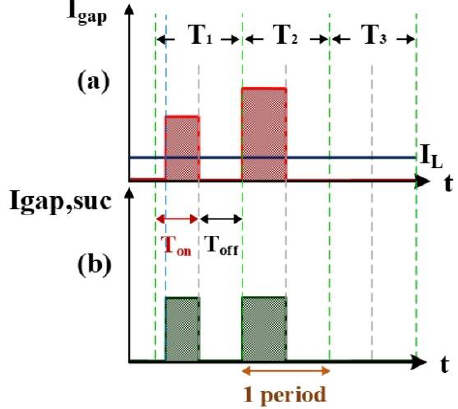
Figure 3. Voltage waveforms: ( a ) V gap , V H , and V L ; ( b ) V L input into the comparator; ( c ) V H input into the comparator; and ( d ) gap electrical discharge.